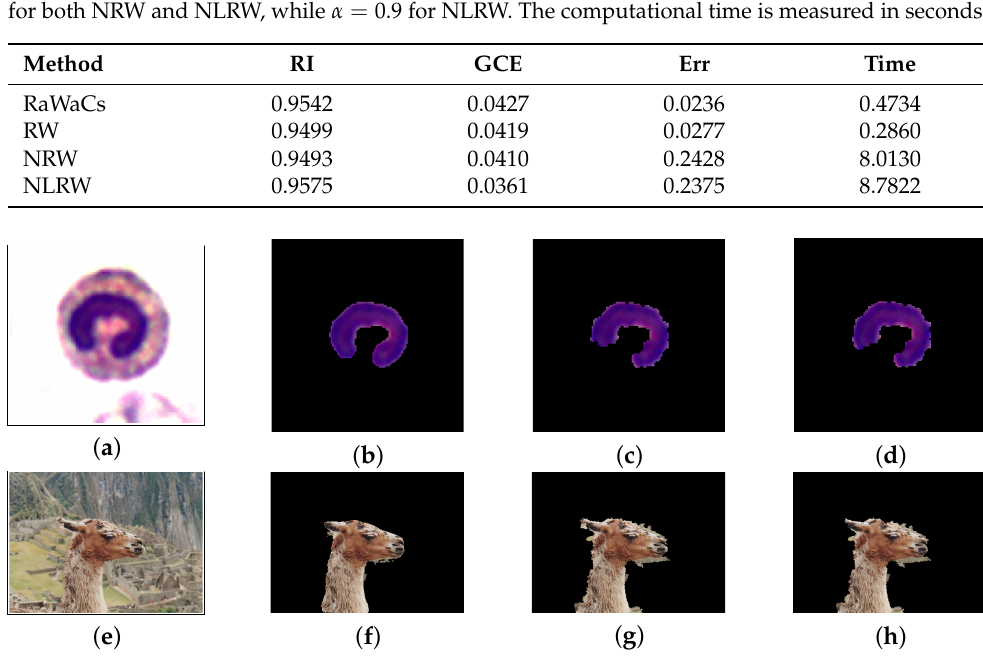
Figure 10. Segmentation results: first row refers to an image of the WBC dataset, while the second row refers to the llama image of the GrabCut dataset. ( a , e ) original image. ( b , f ) RaWaCs. ( c , g ) NRW. ( d , h )